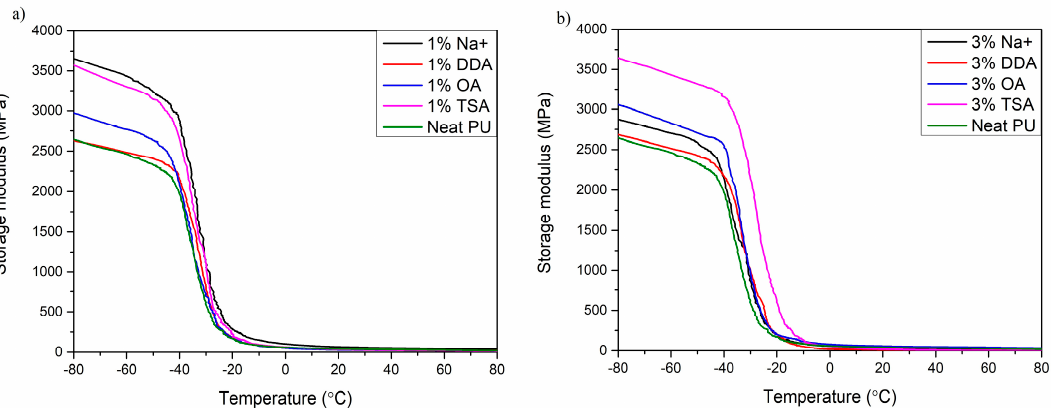
Figure 5. The storage modulus of synthesized nanocomposite thin films. ( a ) Samples with 1% addition of MMT; ( b ) Samples with 3% addition of MMT.